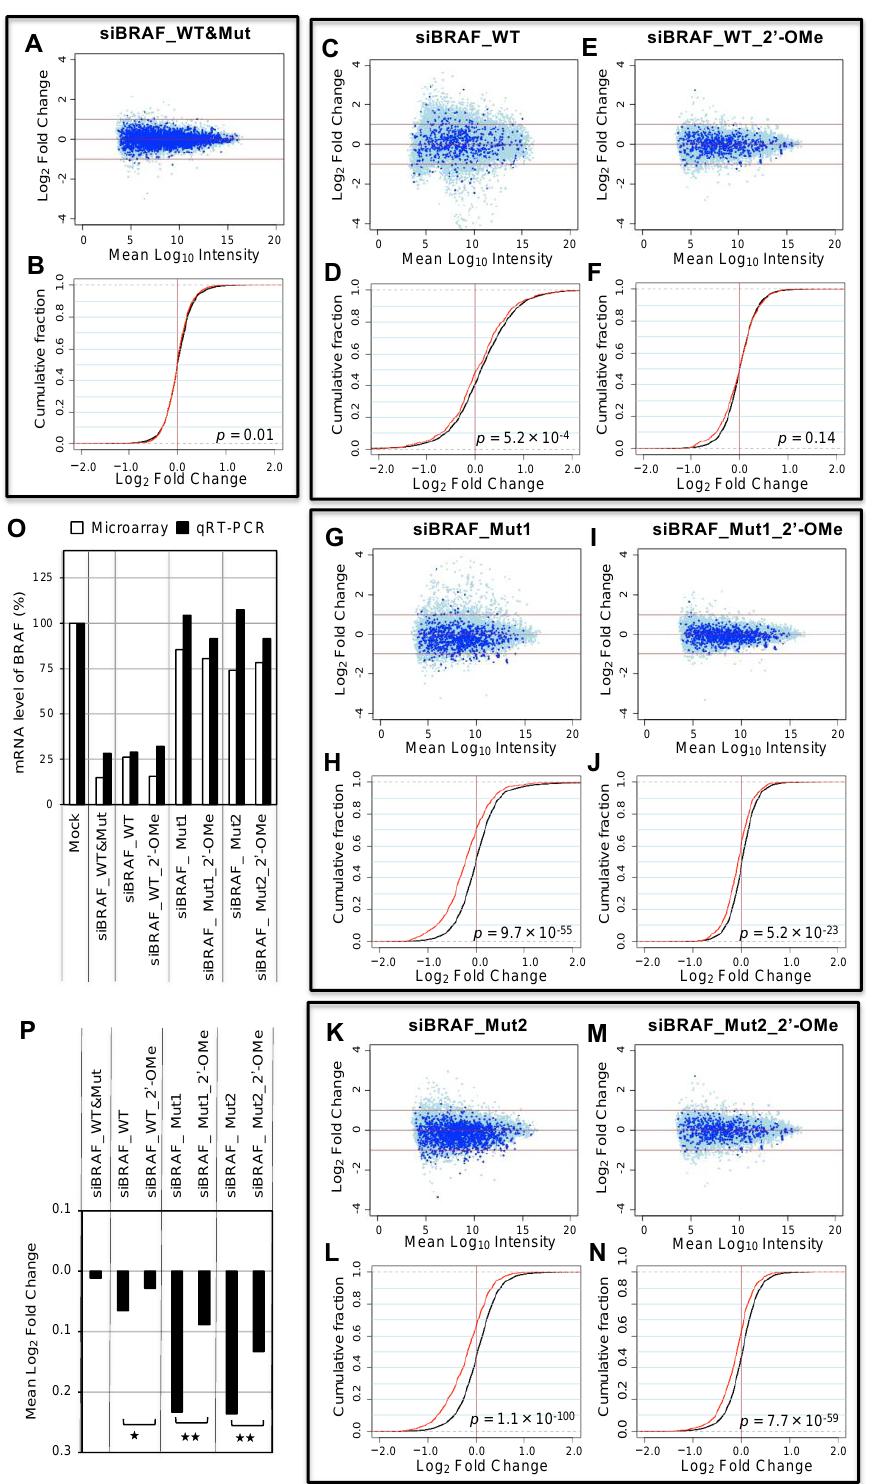
Figure 4. Microarray-based off-target profilings. Microarray profiles of transcripts from the cells transfected with ( A , B ) siBRAF-WT&Mut, ( C , D ) siBRAF-WT, ( E , F ) siBRAF-WT_ 2′ -OMe, ( G , H ) siBRAF-Mut1, ( I , J ) siBRAF-Mut1_ 2′ -OMe, ( K , L ) siBRAF-Mut2, ( M , N ) siBRAF-Mut2_ 2′ -OMe. Results are shown in MA plots ( A , C , E , G , I , K , M ) and cumulative frequency distributions ( B , D , F , H , J , L , N ). Blue dots in MA plots indicate the transcripts with SM sequences of each siRNA. The red lines in cumulative frequency distributions indicate the fraction of transcripts with SM sequences in their 3′ UTRs. The black lines show the transcripts with no SM sequences. Change in the expression level was determined as the log 2 of expression in the siRNA-transected cells compared